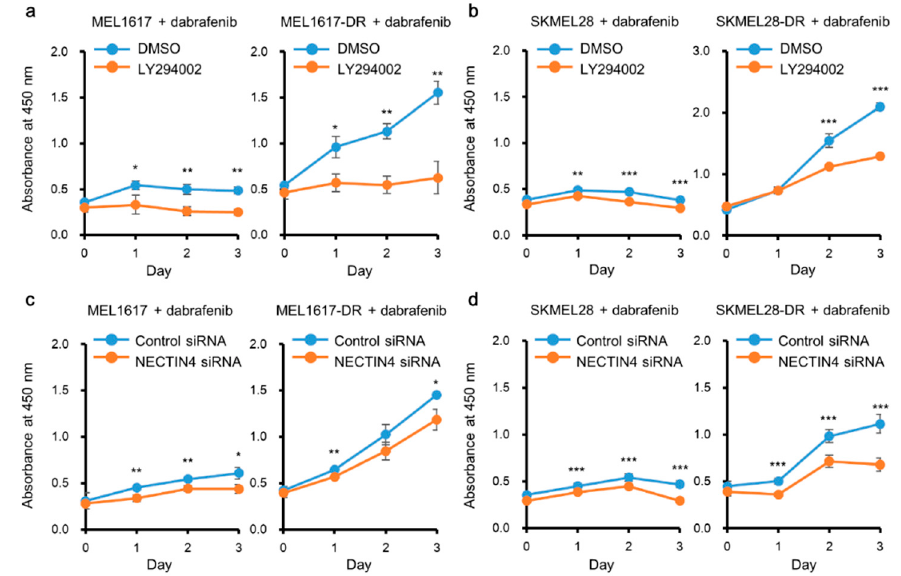
Figure 5. NECTIN4 inhibition increases sensitivity of BRAFi-resistant melanoma cells to BRAFi. ( a ) MEL1617 and ( b ) SKMEL28, and their DR cell lines were treated with DMSO (0.1%) or PI3K inhibitor LY294002 (10 µM) with dabrafenib for 3 days. ( c ) MEL1617 and ( d ) SKMEL28, and their DR cell lines were transfected with control or NECTIN4 siRNA in the presence of dabrafenib for 3 days. Viable cells in each condition were detected using Cell Counting Kit-8 (CCK-8). Experiments were performed in triplicate wells and repeated three times ( n = 9). Data are presented as the mean ± standard deviation. * p < 0.05, ** p < 0.01, and *** p < 0.001 determined by Student’s unpaired two-tailed t -test.